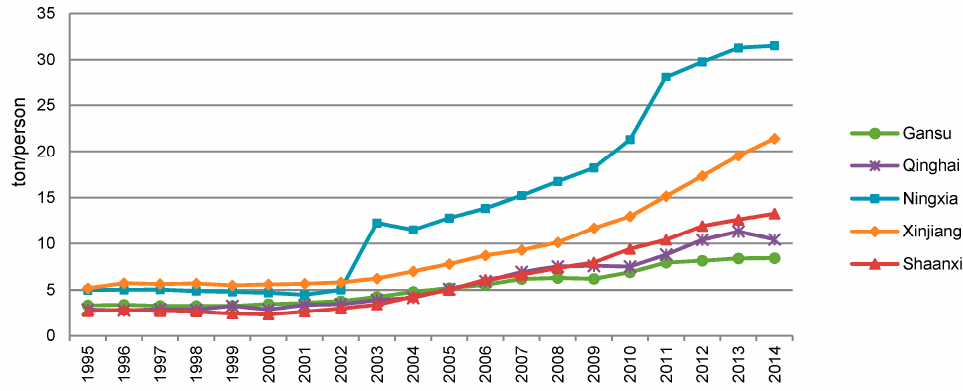
Figure 4. Variation in per capita CO 2 emissions in five provinces.